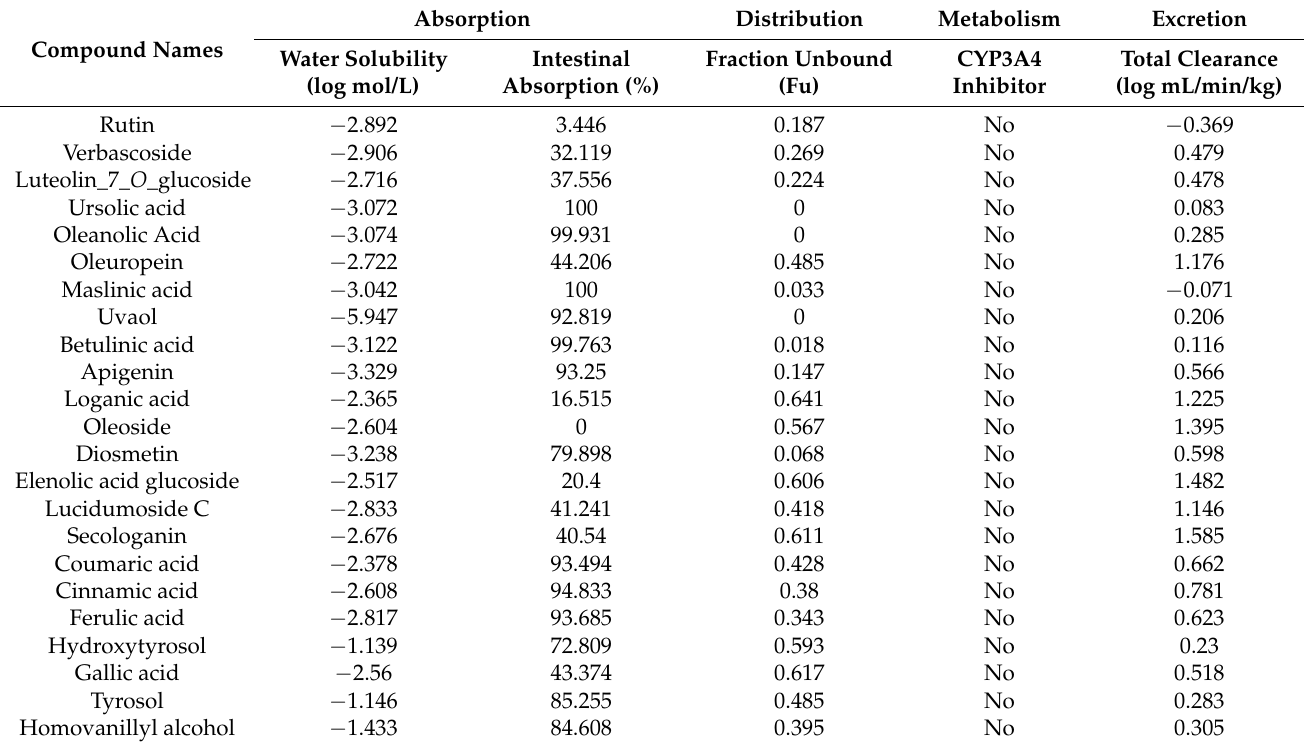
Table 3. Evaluation of the ADME properties of the phytocompounds present in the olive leaf extract (OLE) using pkCSM web server for human